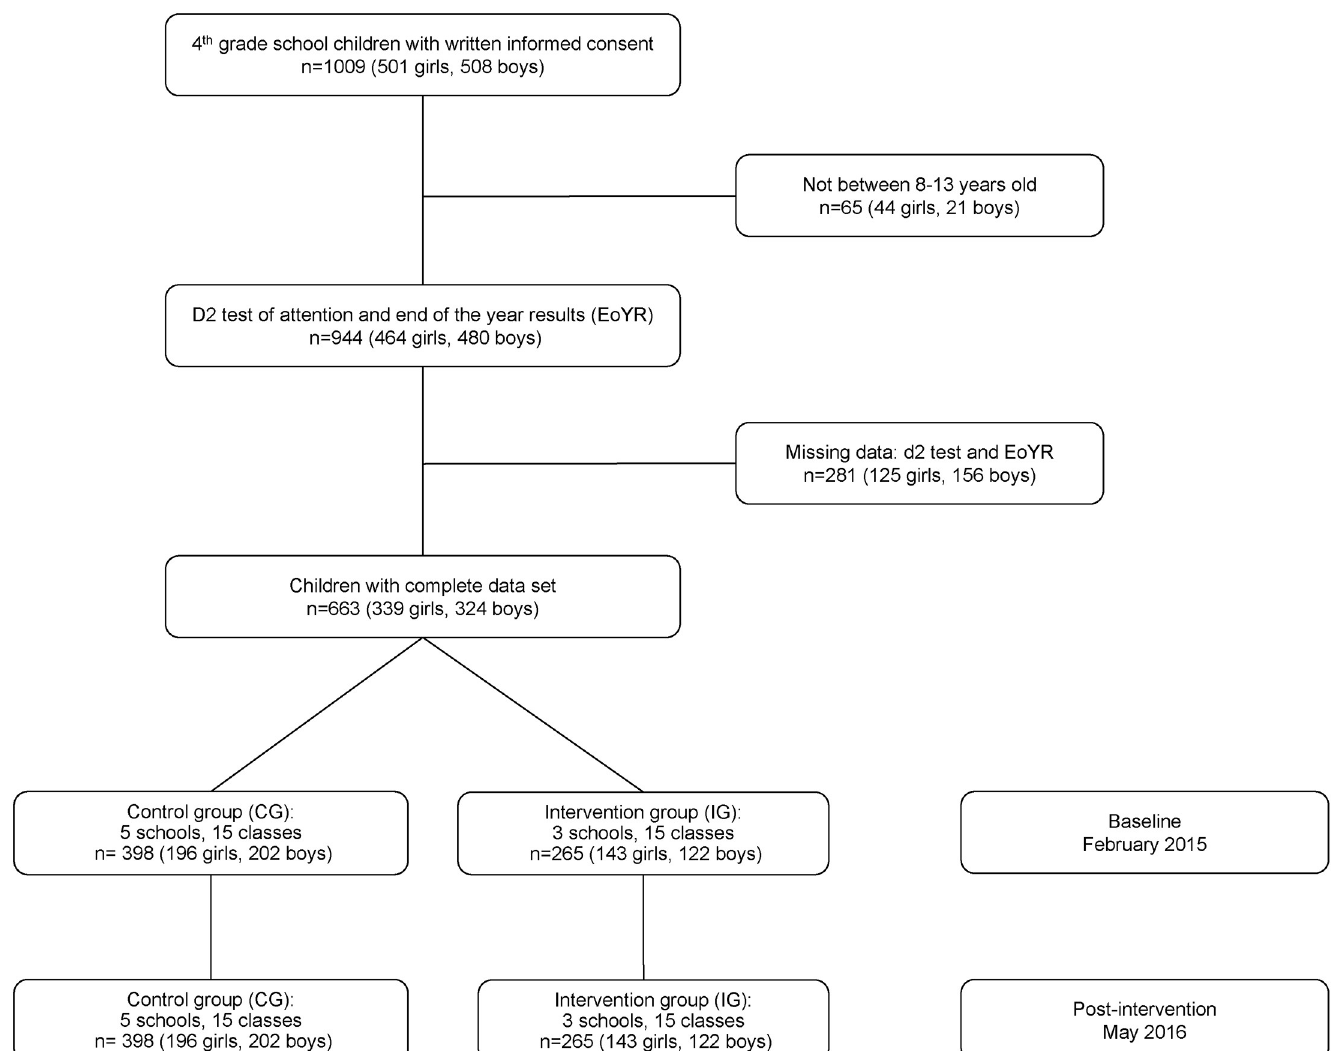
Fig 1. Participant flow chart. Notes: EoYR: end of the year results, average of the four subjects home language, additional language, mathematics, and life skills.